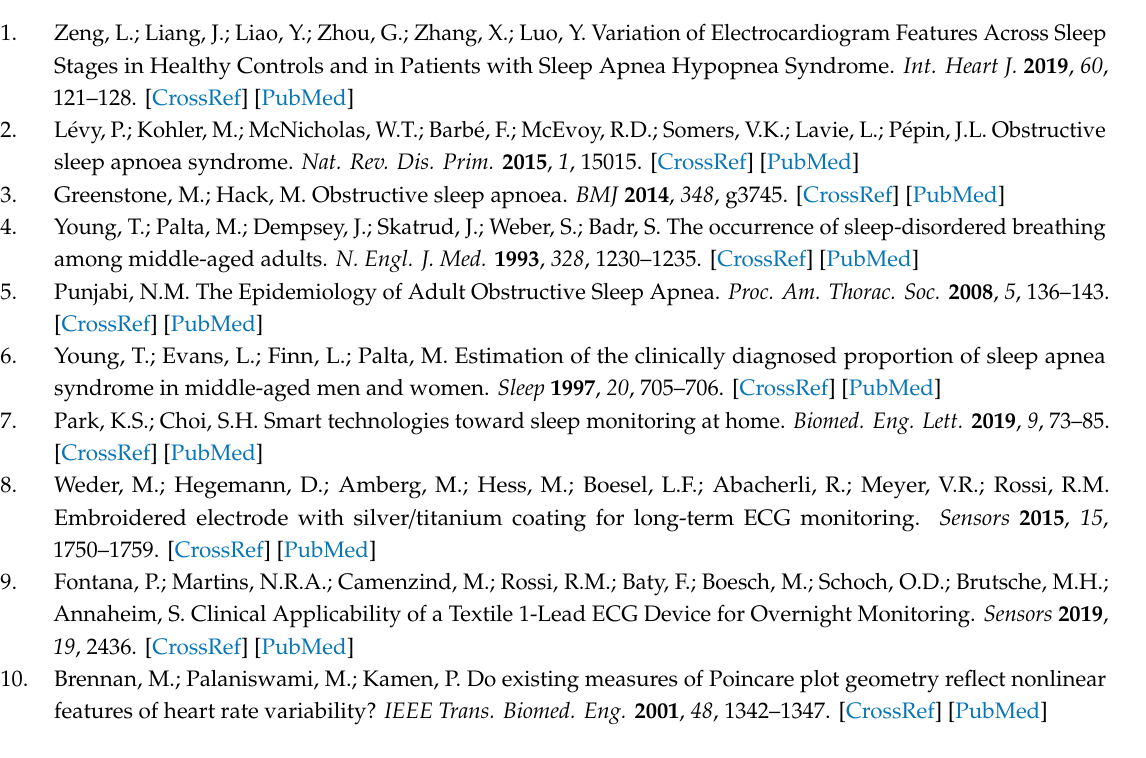
supplementary Document 1: Poincar é plots for single nights. Supplementary Document 2: Artefact percentages and Poincar é standard deviations. Supplementary Document 3: Overnight mean RR-intervals, unfiltered and filtered. Supplementary Document 4: Overnight RR-interval variability, filtered and